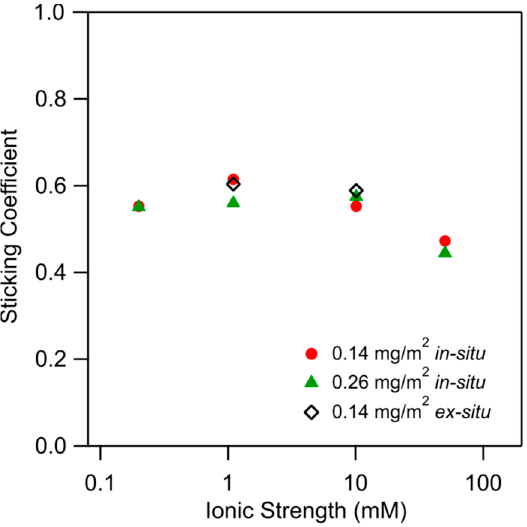
Figure 10. Comparison of the sticking coefficient for nanoparticle deposition on PDADMAC-functionalized silica prepared by in situ and ex situ techniques versus the ionic strength. The adsorbed amount of PDADMAC is indicated. Full and open symbols refer to in situ and ex situ substrates, respectively.